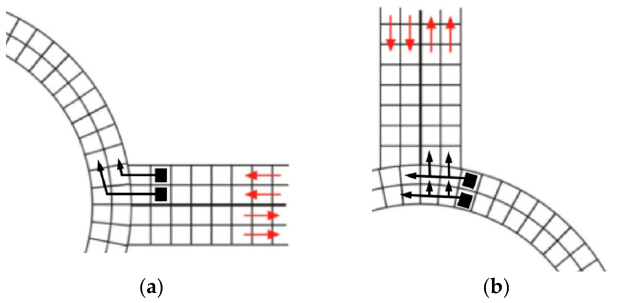
Figure 3. Scenario 2: possible directions of vehicle movement in the roundabout ( a ) enter; ( b ) exit.